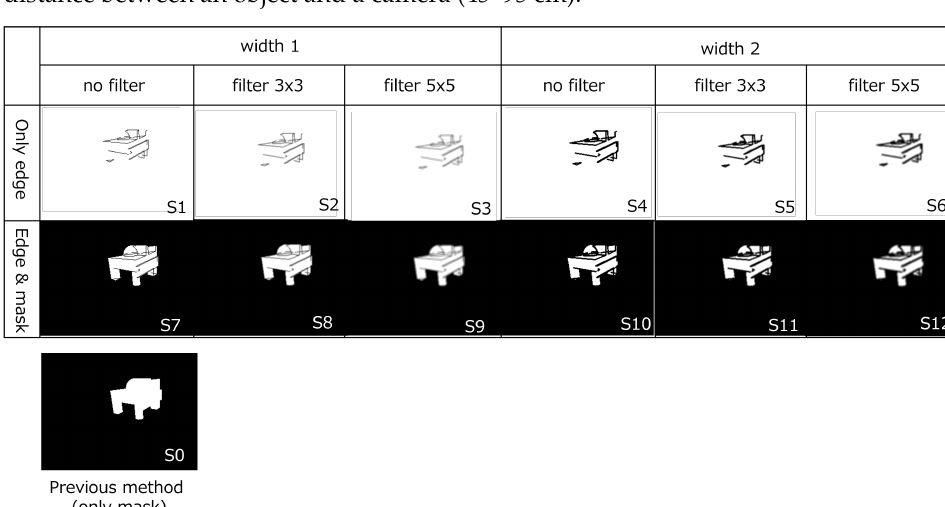
Figure 6. CAD-based edge images used at E1 and E2. Width means the width of the edge line (1 or 2) and filter means the size of the smoothing filter. Each condition has an and mask option mentioned in Figure 2. The previous method uses a silhouette image (S0). S1 to S12 denote the indices of the conditions proposed by